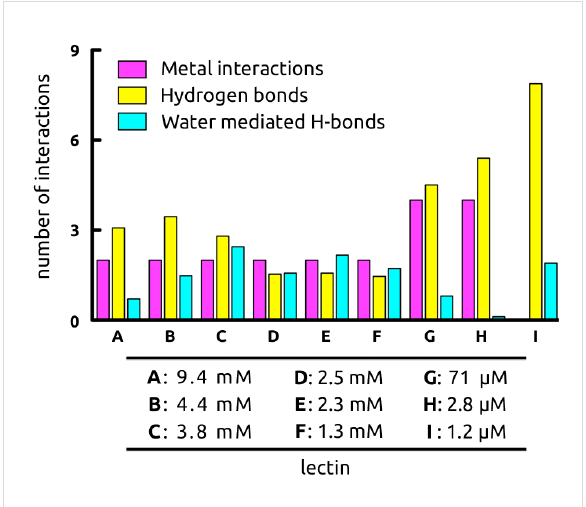
Figure 3: Dynamic mannose–receptor interactions (20 ns MD simula- tions), grouped according to the nature of the interaction. Metal inter- actions with Ca 2+ are colored in purple, hydrogen bonds highlighted in yellow, and water-mediated interactions in cyan. ( A ) BDCA-2, ( B ) langerin, ( C ) SP-D, ( D ) DC-SIGNR, ( E ) DC-SIGN, ( F ) rat MBP, ( G ) LecB, ( H ) BC2L-A, ( I ) FimH LD